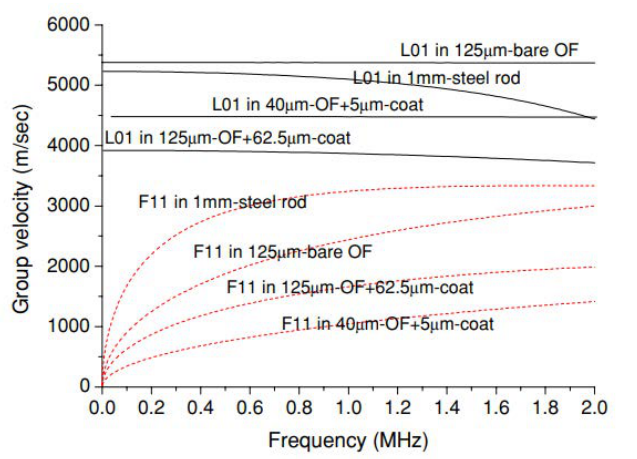
Figure 15. Dispersion curves for optical fiber of different diameters, with and without the polyimide coating. Dispersion curves of the reference steel rod are also plotted [98]. Reprinted with permission from [98] ©IOP Publishing.